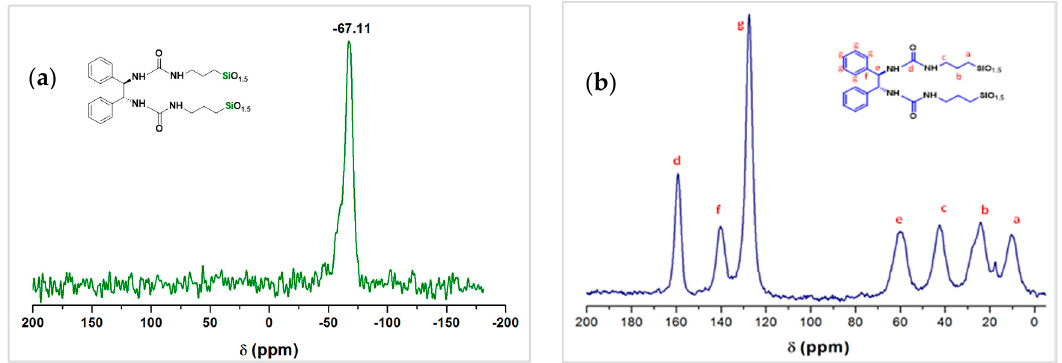
Figure 10. ( a ) Solid-state 29 Si CP-MAS NMR spectroscopy of chiral PMO NPs and ( b ) solid state 13 C CP-MAS NMR spectroscopy of chiral PMO NPs.